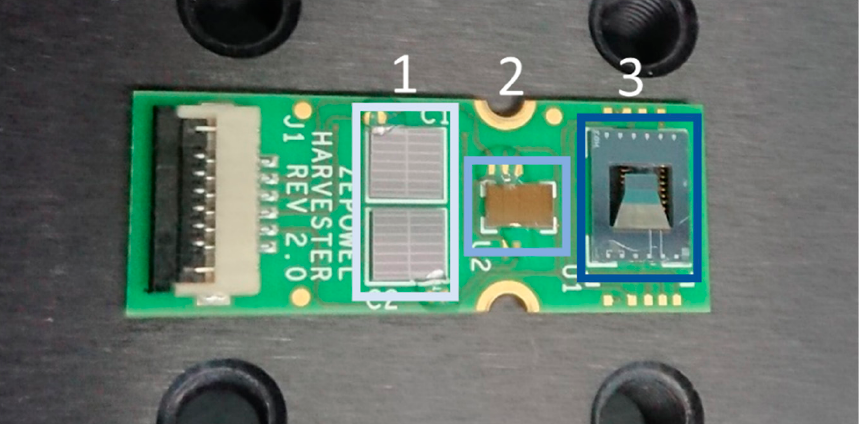
Figure 10. Photograph of a complete module comprising of two capacitors (1.4 µF each) (1), one ASIC (2) and one design 2 harvester (3).